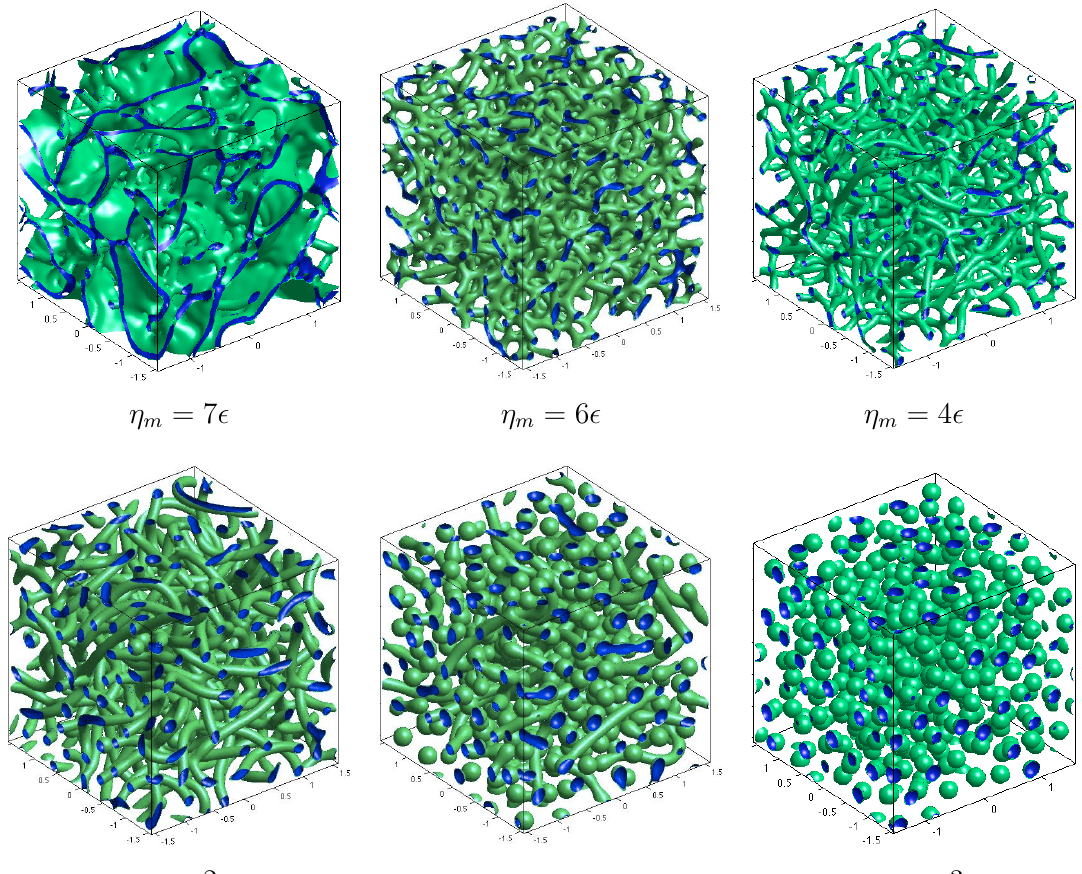
Figure 2. Level sets u = 0 . 4 (green) and u = 0 . 45 (blue) of quasi-equilibria of the solvent phase resulting from the gradient flow Equation (6) with periodic boundary conditions. Each simulation starts from an identical initial data, which was chosen to be randomly 0 or 1 at each grid point with a 20% solvent volume fraction. The difference between the simulations lies in the value of the mixture parameter, η . The binary well W has tilt τ = 0 . 4 , m b − (cid:15) = 0 . 03 , E = 1 , and η = 5 (cid:15) , yield (left to right) bilayer-pore mixture, a highly branched b h pore network, a pore network, disconnected pores, a pearled pore and micelle mixture, and isolated